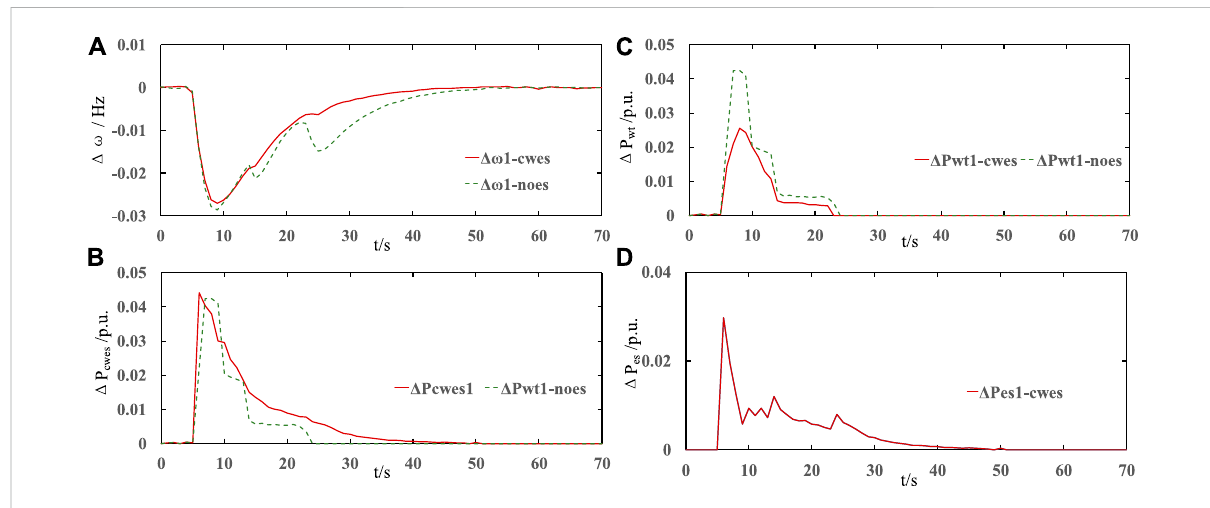
FIGURE 14 Test results under fl uctuating wind speed: (A) frequency simulation trajectory under the DMPC-CWES and no-ES strategy in the 1st area, (B) active power of the wind farm under the DMPC-CWES and no-ES strategy in the 1st area, (C) active power of the CWES under the DMPC-CWES and no-ES strategy in the 1st area, and (D) active power output curve of the ES.